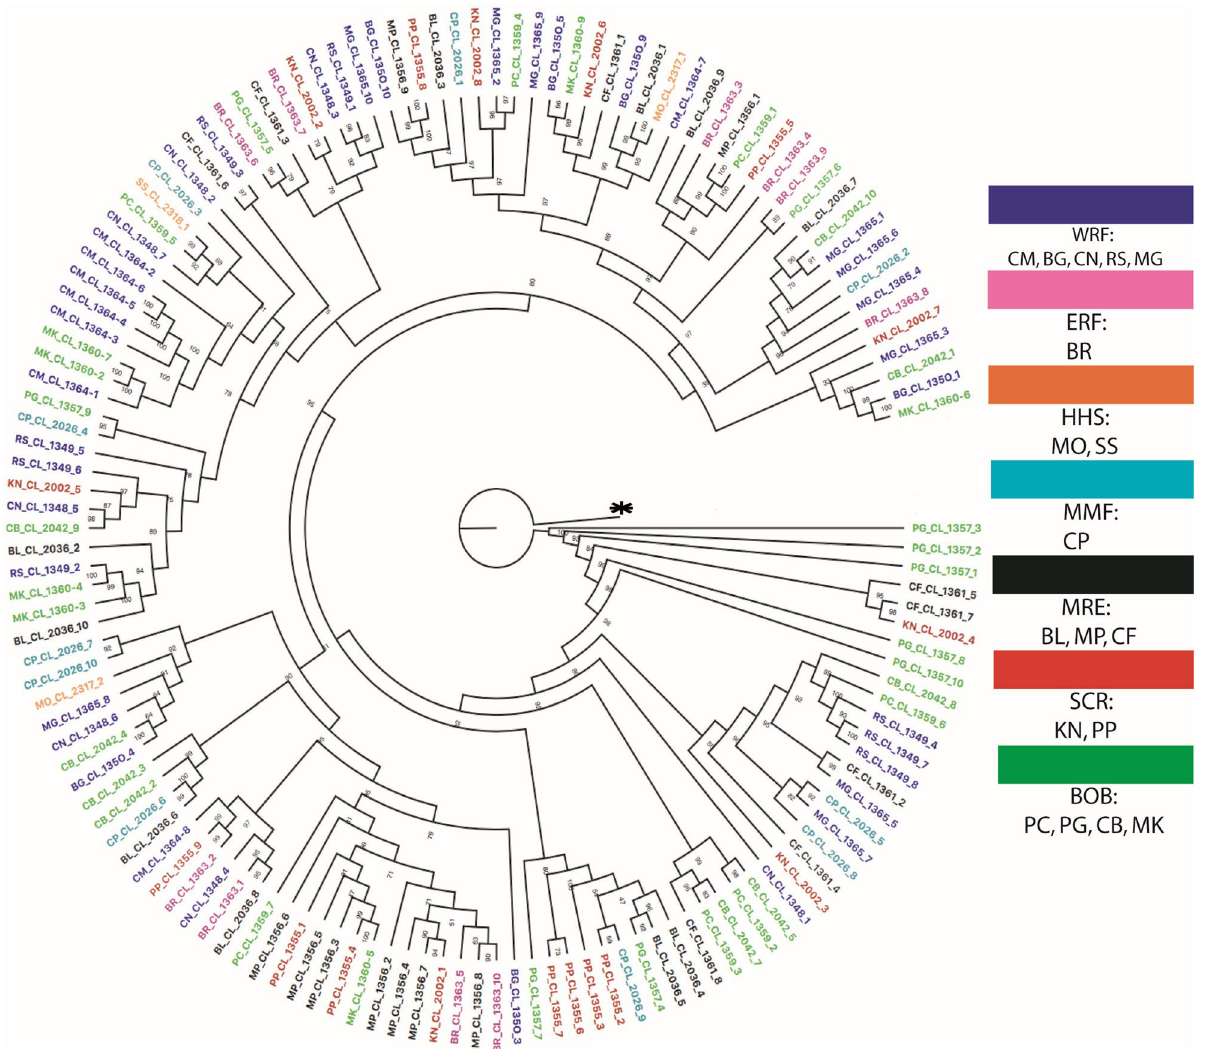
Figure 3. A ML tree based on sequences data concatenating 2,461 loci reconstructed by using IQtree v1.6.9 (http:// www. iqtree. org/) with 1,000 bootstrap replicates. Each color indicates specific habitat group and abbreviated letter indicates sampling location (Table 1). CM, Chilmari; BG, Balashi Ghat; CN, Chapai- Nababganj; RS, Rajshahi; MO, Mohanganj; SS, Someshwari, Durgapur; MG, Manikganj; BR, Bhairab; CP, Chandpur ; KN, Khulna; PP, Pirojpur; BL, Bhola; MP, Mohipur; CF, Char Fasson; PC, Pokhkhir Char; PG, Patharghata; CB, Cox’s Bazar; MK,